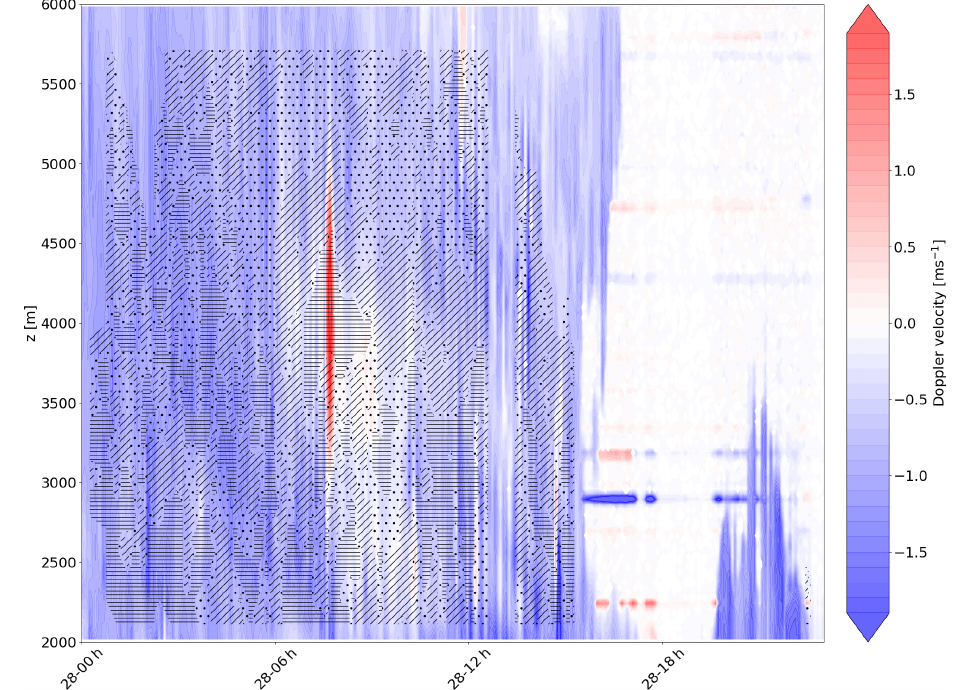
Figure A2. Same as A1 for EV1 with MXPOL Doppler